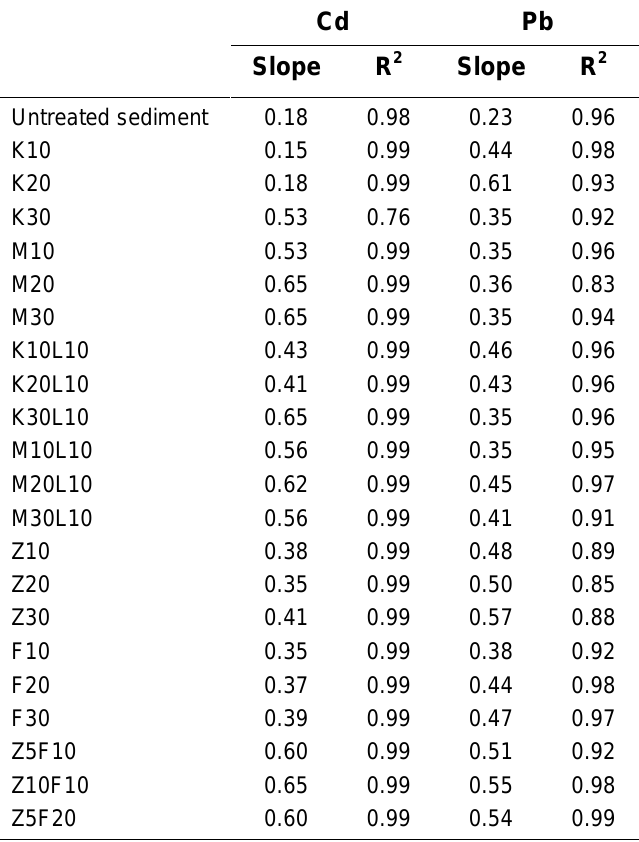
Regression Analysis Results for Cd and Pb